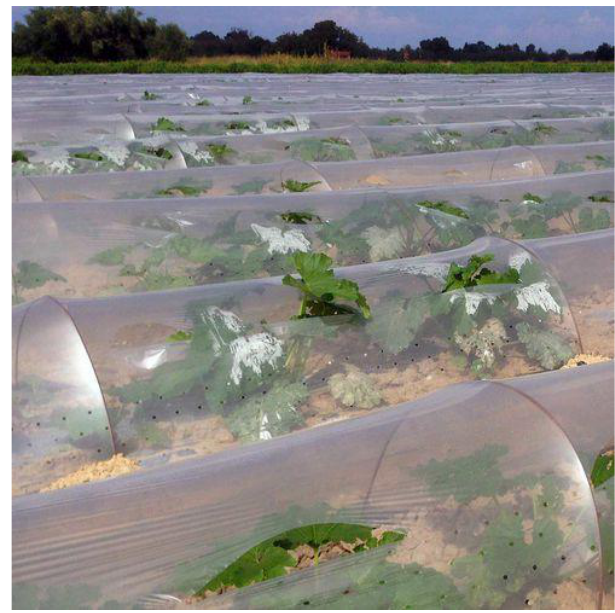
Figure 17 . Low tunnel transparent film. Reprinted from website [91]. Figure 17. Low tunnel transparent film. Reprinted from website [91].